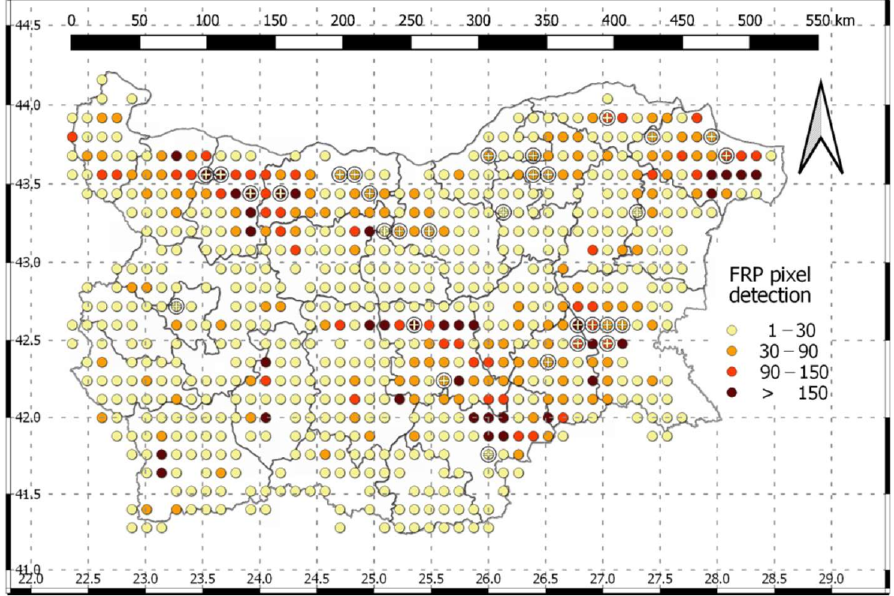
Figure 10. Map of “hot spots” of fire activity over Bulgaria, SE Europe based on long-term satellite observations (June–September, 2004–2019) using the LSASAF FRP-Pixel product. The fire numbers are the sum of the fire pixels (4 × 5 km MSG resolution over Bulgaria) detected and resampled in a 10 × 10 km plot. The “+” sign indicates locations where the trend passed the Mann–Kendall significance test at the 5%